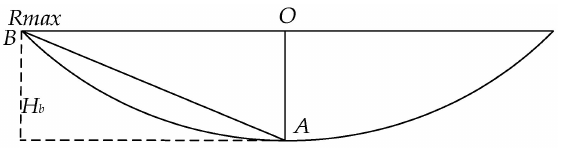
Figure 6. Horizontal section view of the radar’s detection threat